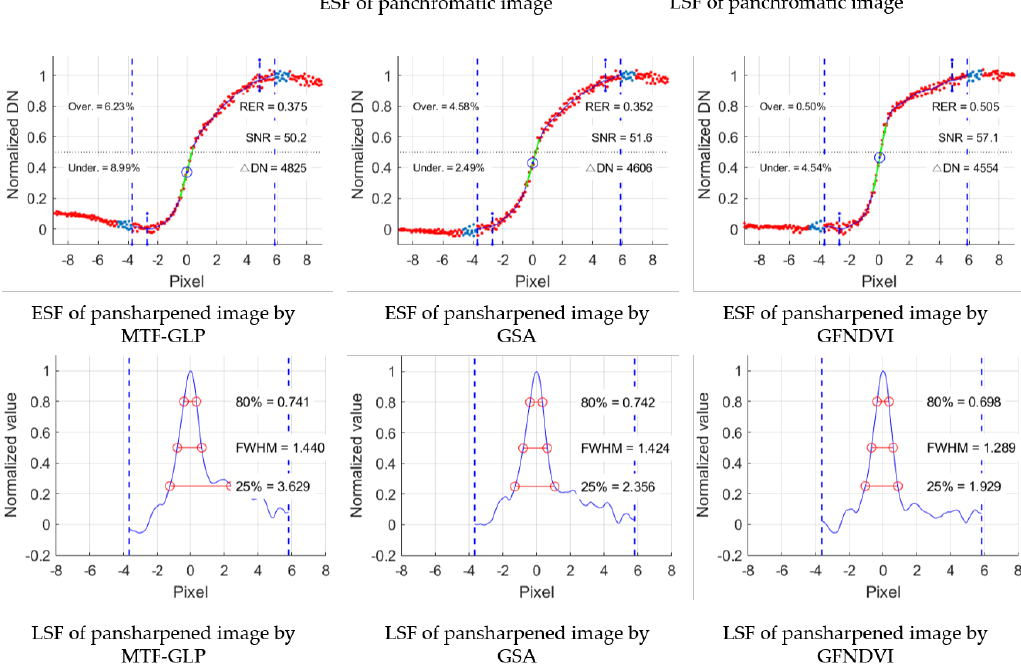
Figure 11. The ESF and LSF curves along the pansharpened image generated by each algorithm (Baotou region).